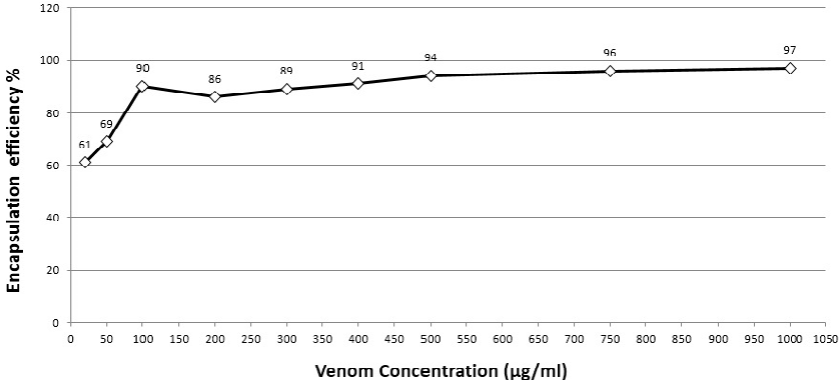
Fig. 3. The influence of Vipera albicornuta venom initial concentration on EE (CS: 2.5 mg/mL, TPP: 1 mg/mL).